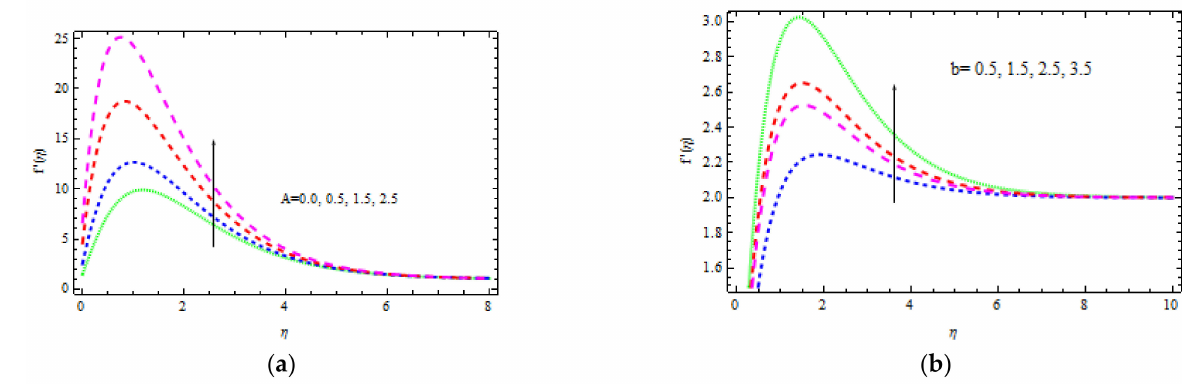
Figure 2. Inspiration of A ( a ) and b ( b ) on velocity.